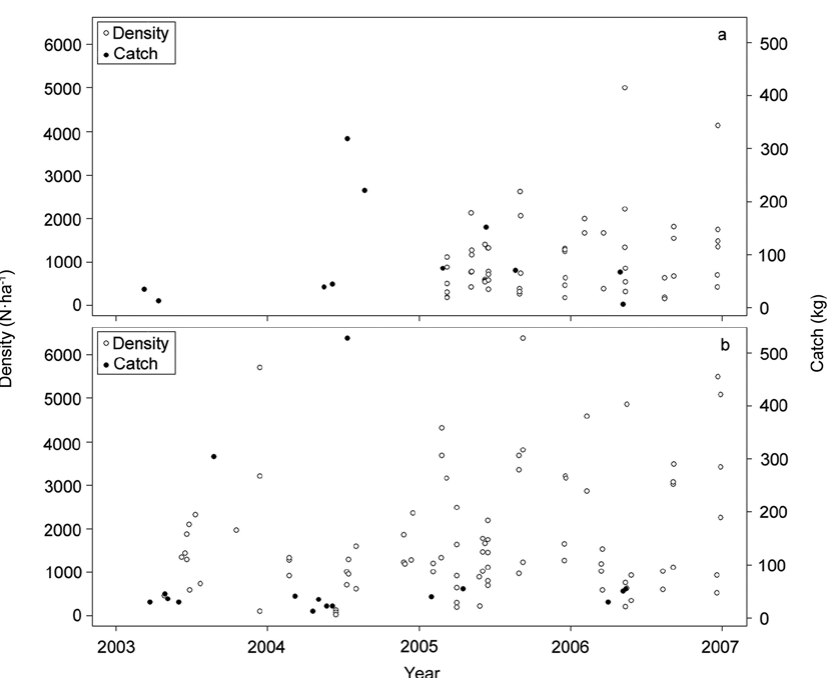
Fig. 3. – Catches obtained in the spearfishing competitions (black points) and abundances of the fish assemblages targeted by the spear fishery obtained by UVCs (white points) in Mera (a) and O Portiño (b) between 2003 and 2007.